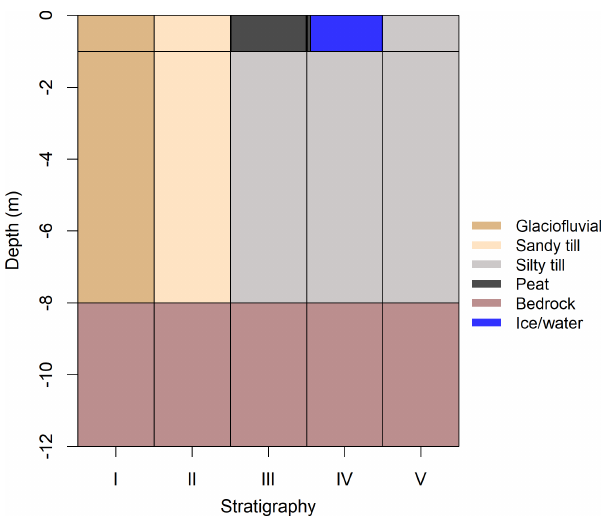
Figure 7. Soil profiles for the different terrain types used to par- tition surface temperature observations. Parameters for each of the subsurface materials are provided in Table 2. The stratigraphic unit (I–V) associated with each of the terrain types is listed in Table 3. In the long-term simulation, the layer of bedrock is extended to 50m.